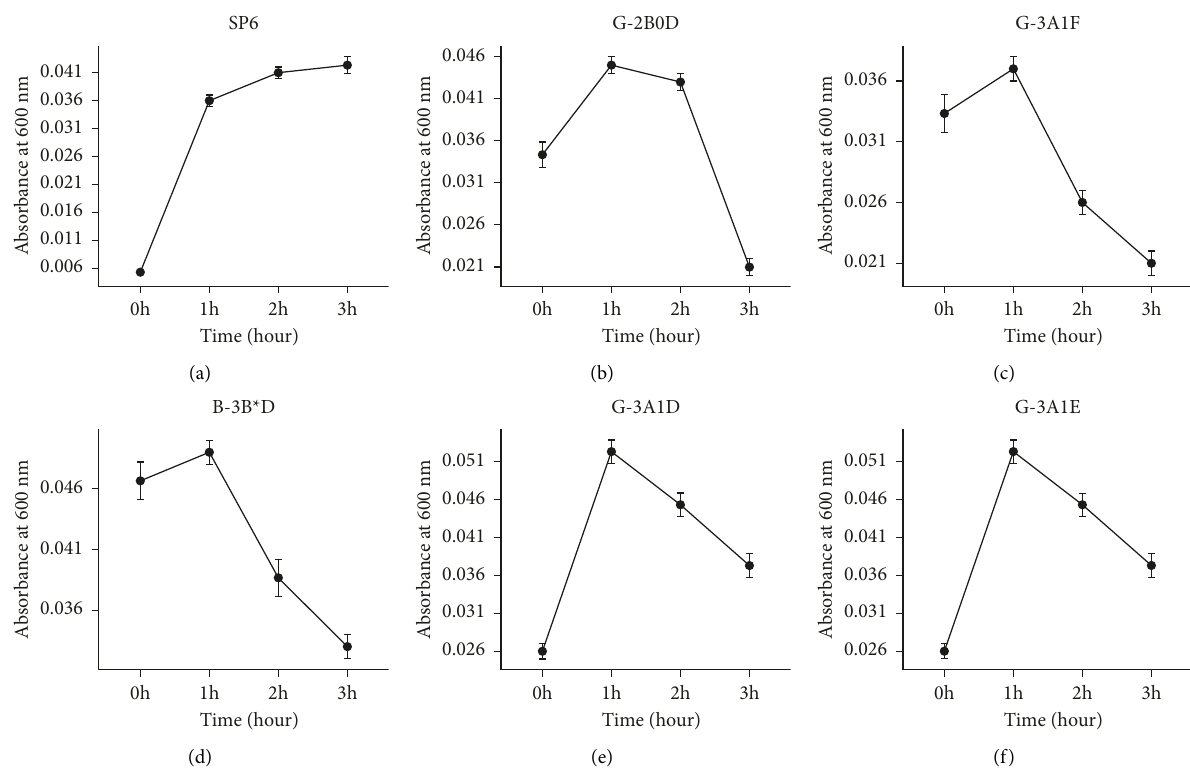
Figure 3: Growth rates of Salmonella typhimurium strains (a) SP6, (b) G-2B0D, (c) G-3A1F and Salmonella enteritidis strains (d) B–3B (e) G-3A1D, and (f) G-3A1E in simulated gastric juice. The bars represent the standard deviation of the mean. The graph is generated in RStudio.